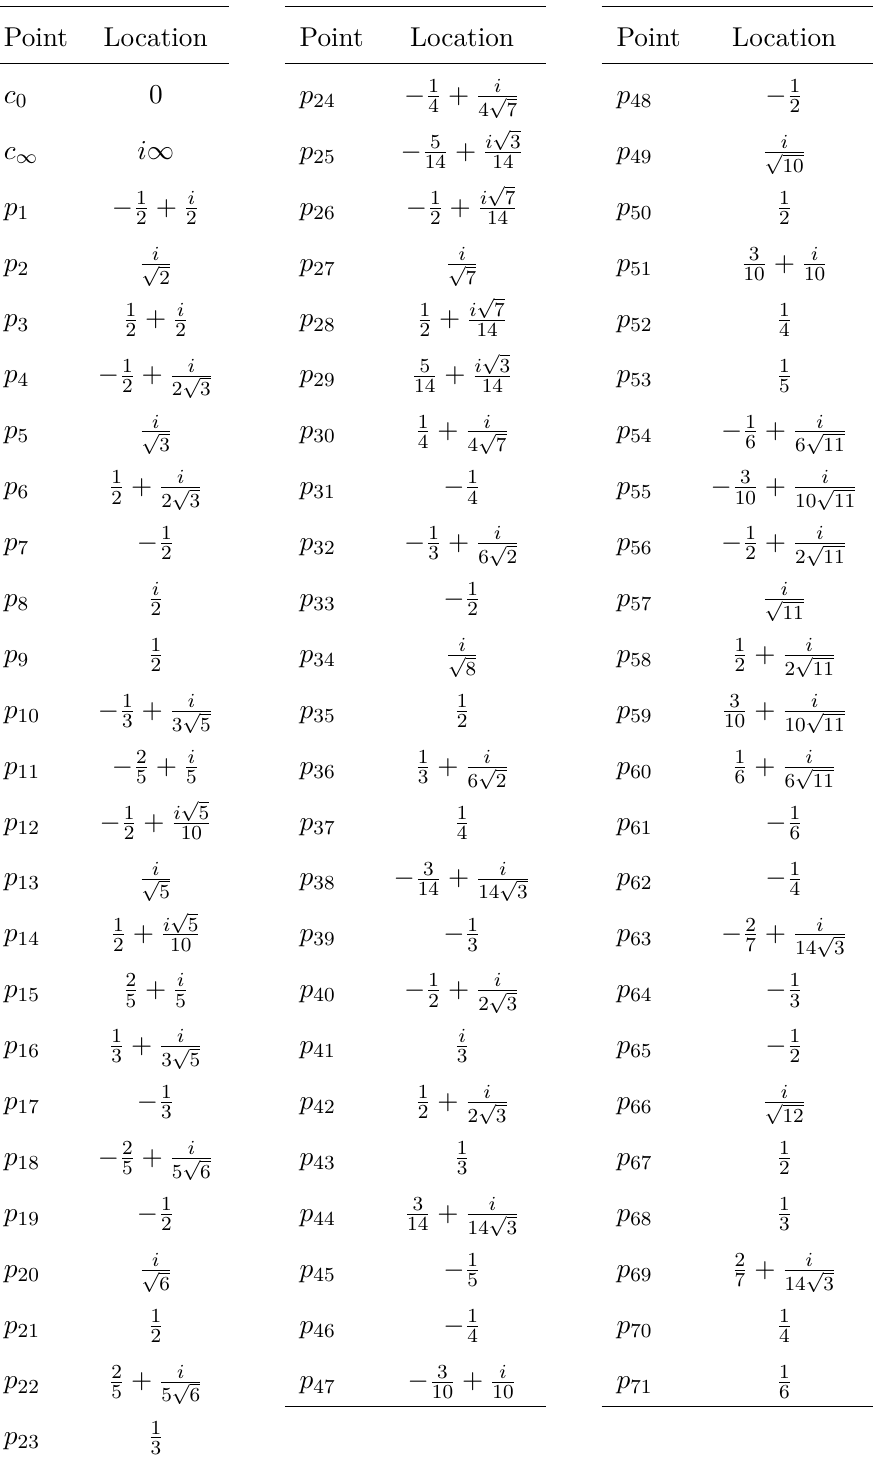
Table 6 . Special points in the Γ 0 ( N ) fundamental